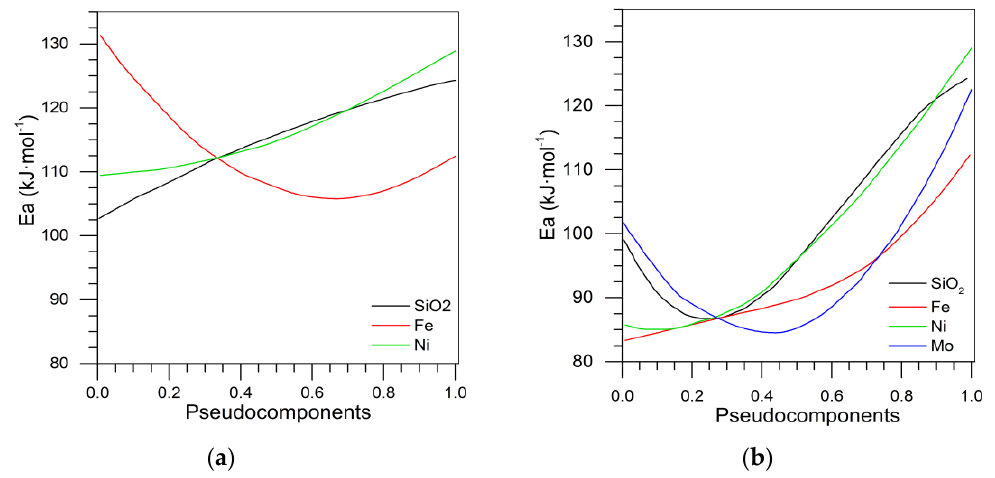
Figure 21. Trace plot for the activation energy for the series ( a ) Si-Fe-Ni and ( b ) Si-Fe-Ni-Mo at 20% of